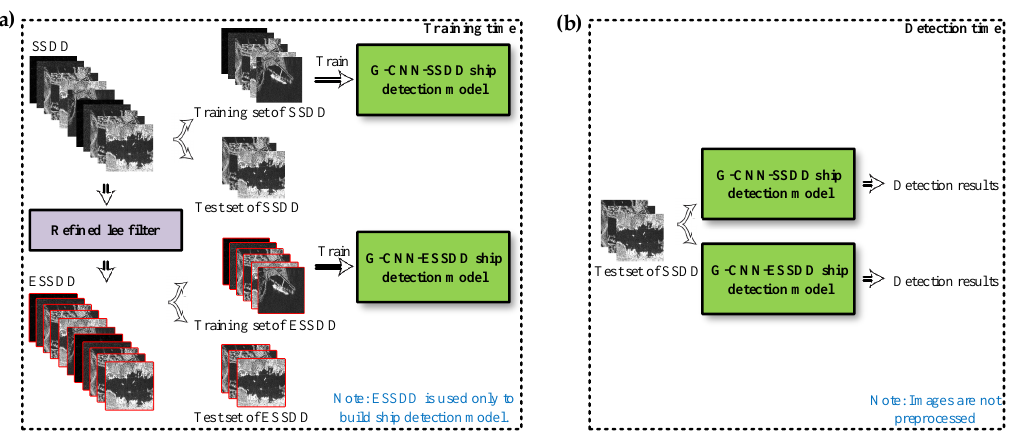
Figure 12. Explanation of training time and detection time. ( a ) Training time; ( b ) detection time.